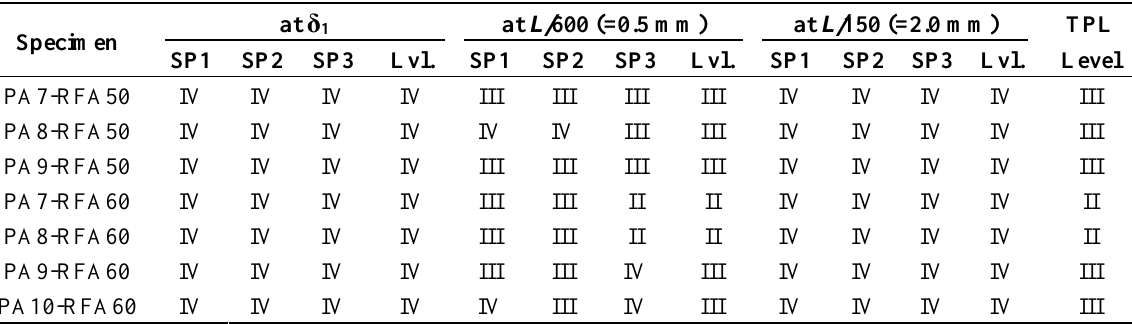
Table 7. Toughness performance